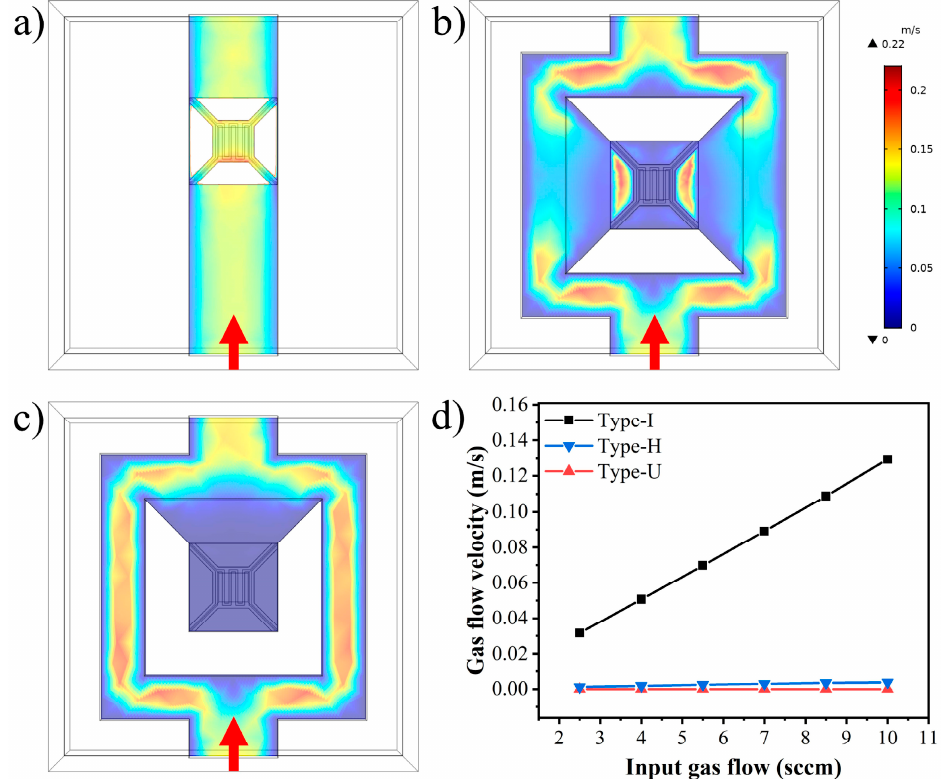
Figure 3. The simulation results: the flow velocity distribution at 0.5 μ m above the hot film in ( a ) Type-I, ( b ) Type-H, ( c ) Type-U, the arrows indicate the flow direction, ( d ) the gas flow velocity at 0.5 μ m above the center of the hot film in different designs.